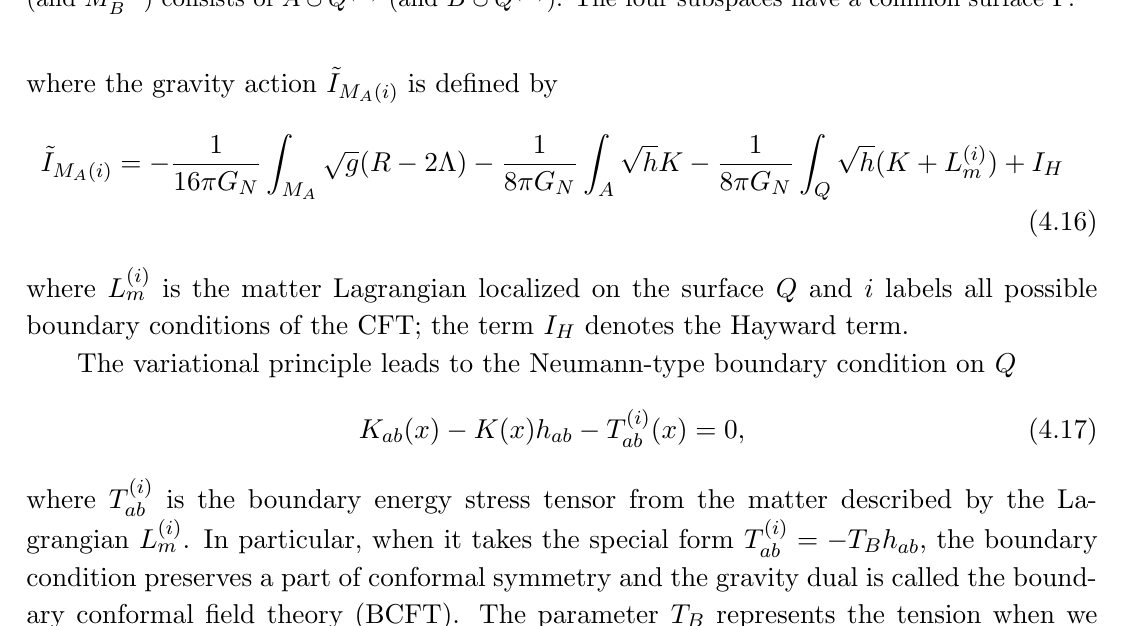
; M ( (cid:0) ) ; M (+) and M ( (cid:0) ) , which are extended A A B B A